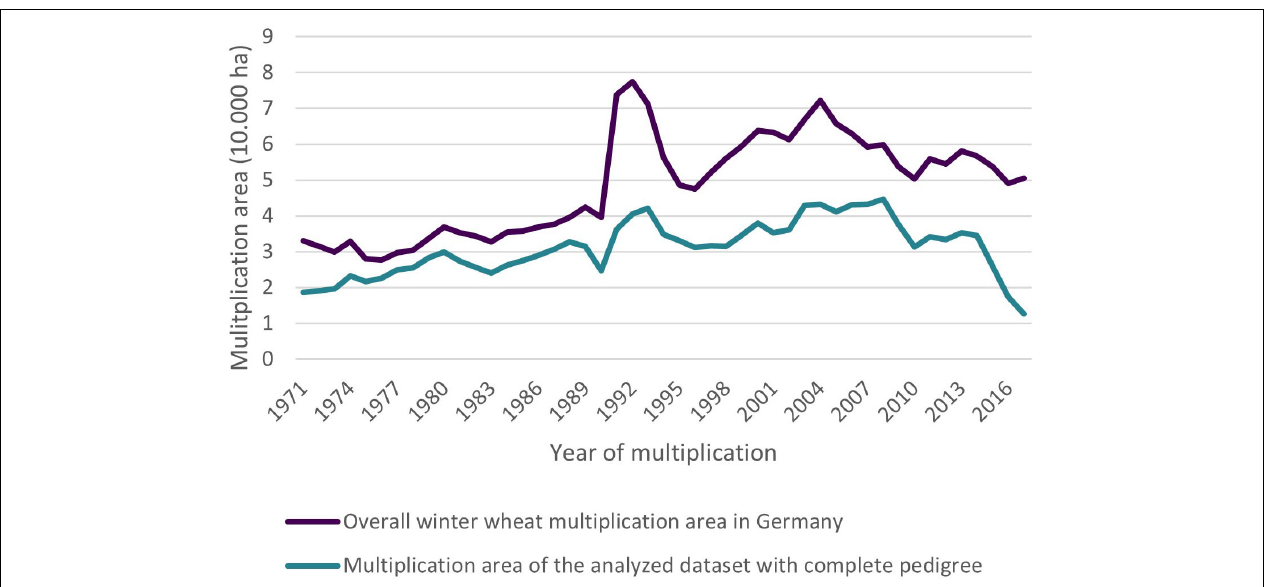
FIGURE 1 | Development of the overall winter wheat multiplication area from 1971 to 2017 in Germany and the area of all varieties in the analyzed data set with full pedigree information, Source: Own calculations with data from Kempf (2019).